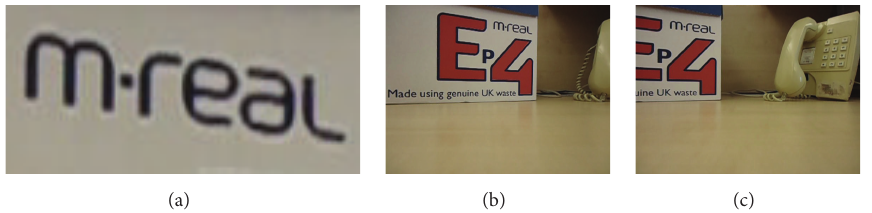
Figure 13: A template and some sample video frames for template matching. A moving handheld camera is used to capture this video in which a text template is matched.